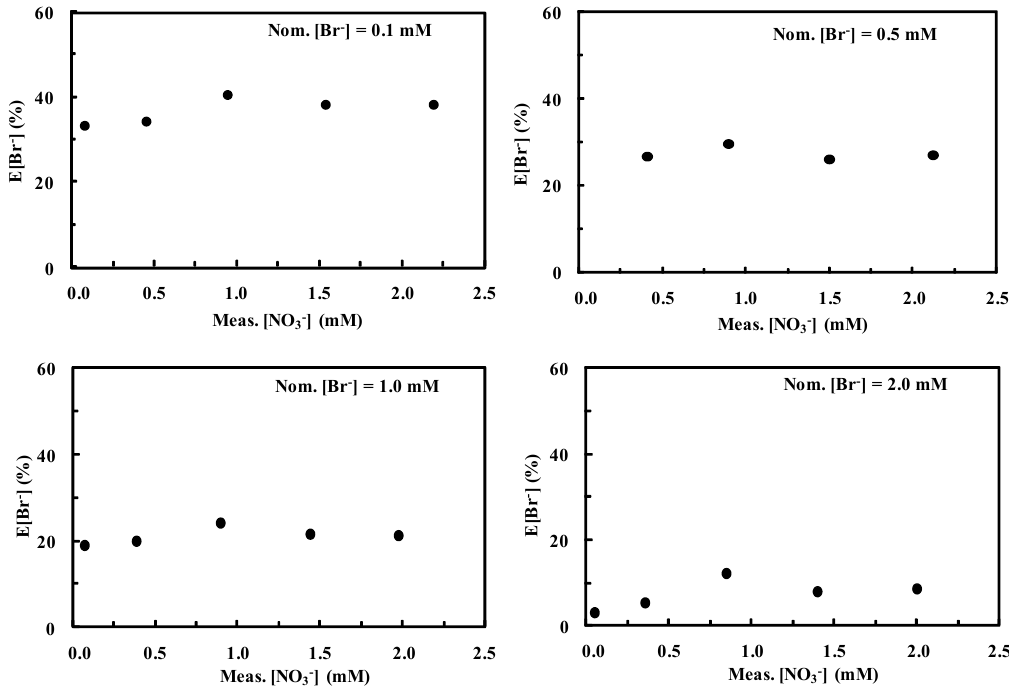
Figure 3. Dependence of E[Br − ] on measured [NO 3 − ] (Meas.[NO 3 − ]) at fixed bromide concentration. Eluent 1 mM NaHCO 3 –3.2 mM Na 2 CO 3 . Figures were obtained by integrating the peaks according to Figure 1.